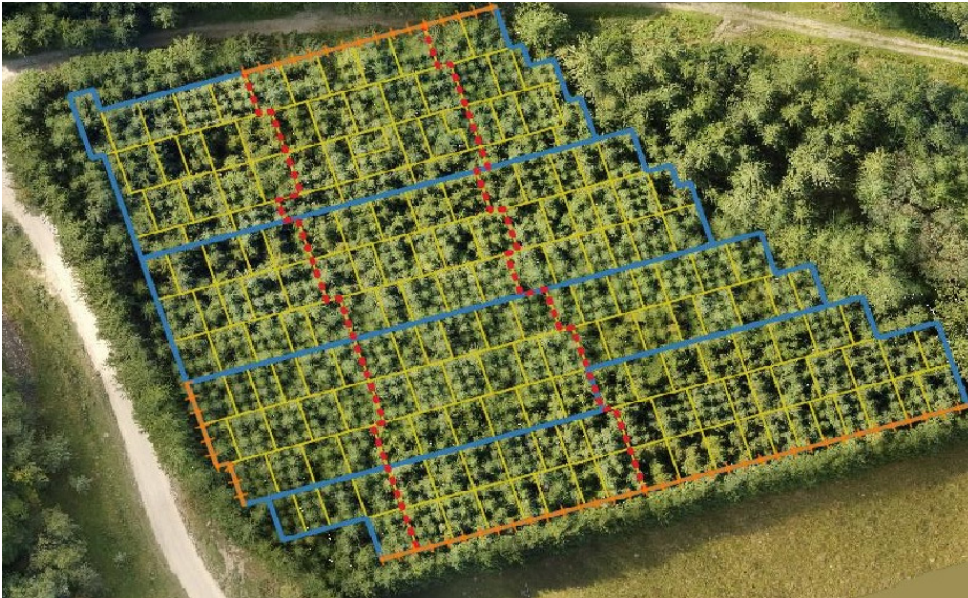
Figure 2. The spatial distribution of families (yellow), replication (blue), perimeter affected by marginal effect (orange), and the slope position (red).